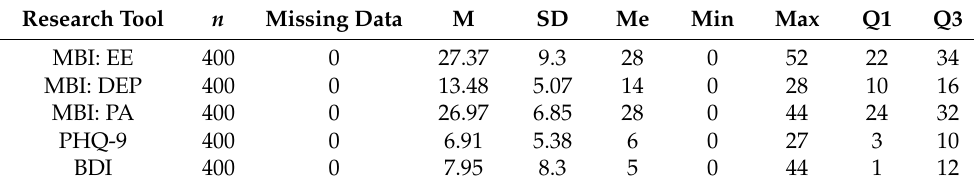
Table 2. Results of standardized tools: MBI, PHQ-9, and